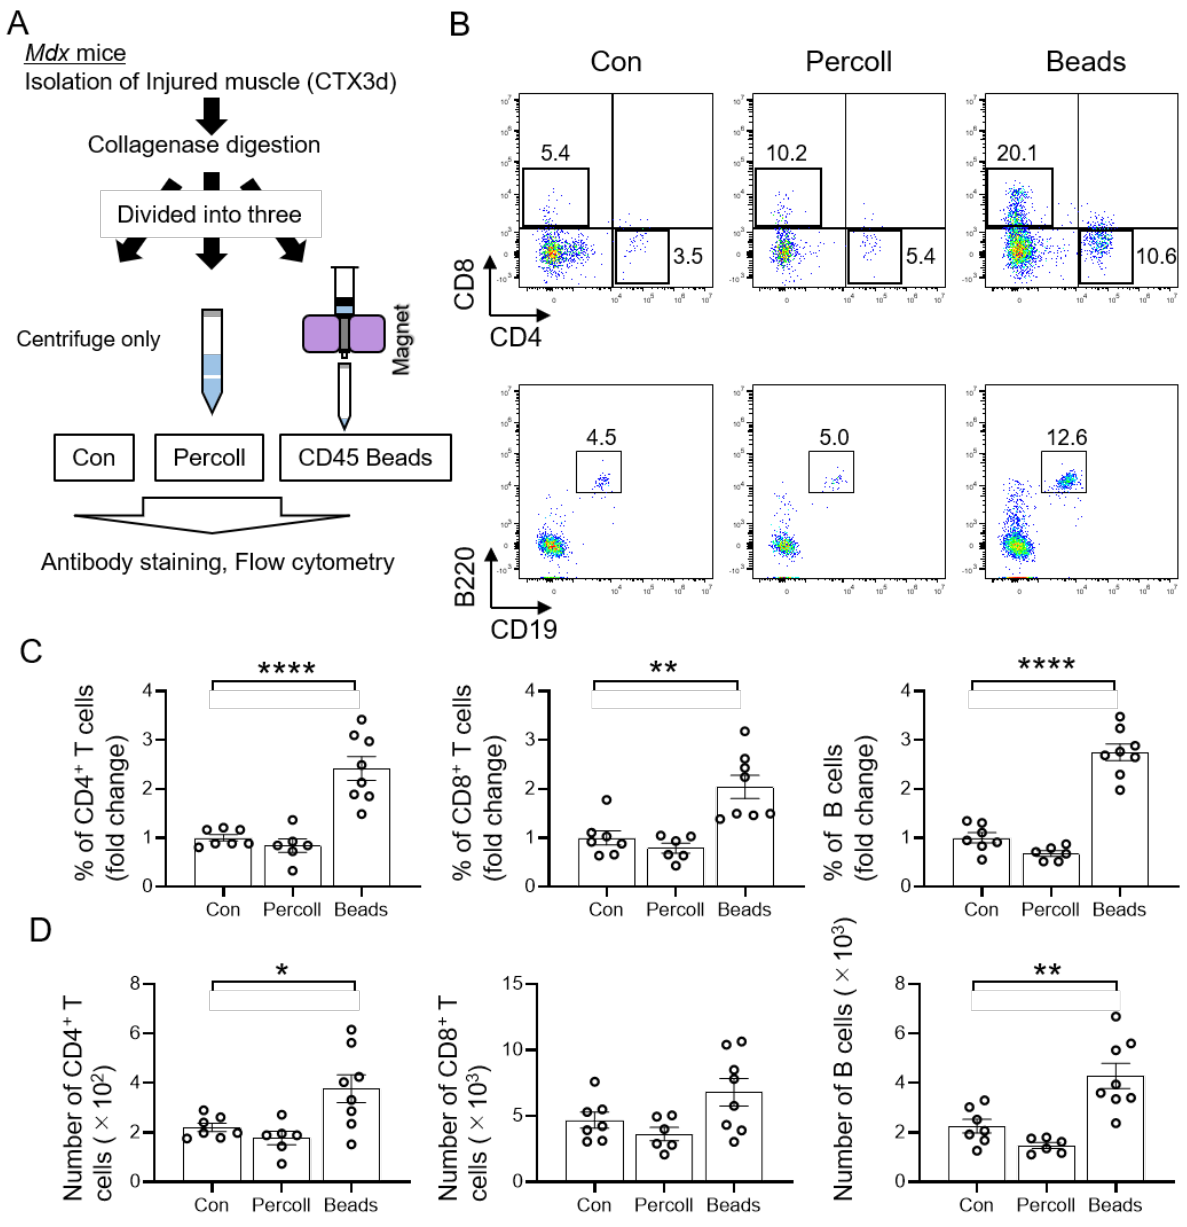
Figure 3. Isolation of T and B cells using CD45 beads in mdx mice. ( A ) Schematic representation of the experimental workflow for the analysis of injured muscle on day 3 after injury with Percoll and